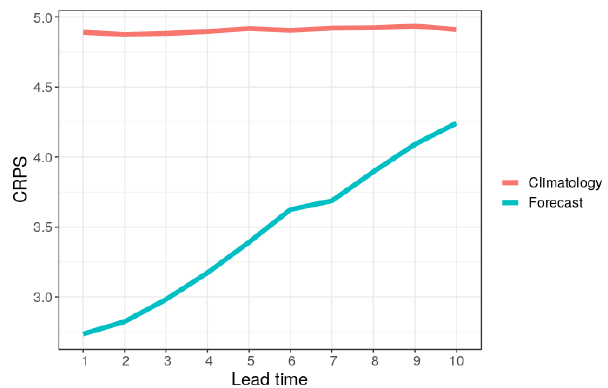
Figure 3. CRPS for the ensemble fire danger forecast (blue line) and the CLIM database constructed using a random selection of ERA5 years not including the verifying year (red line). Data have been globally aggregated and the forecast is available up to day 10